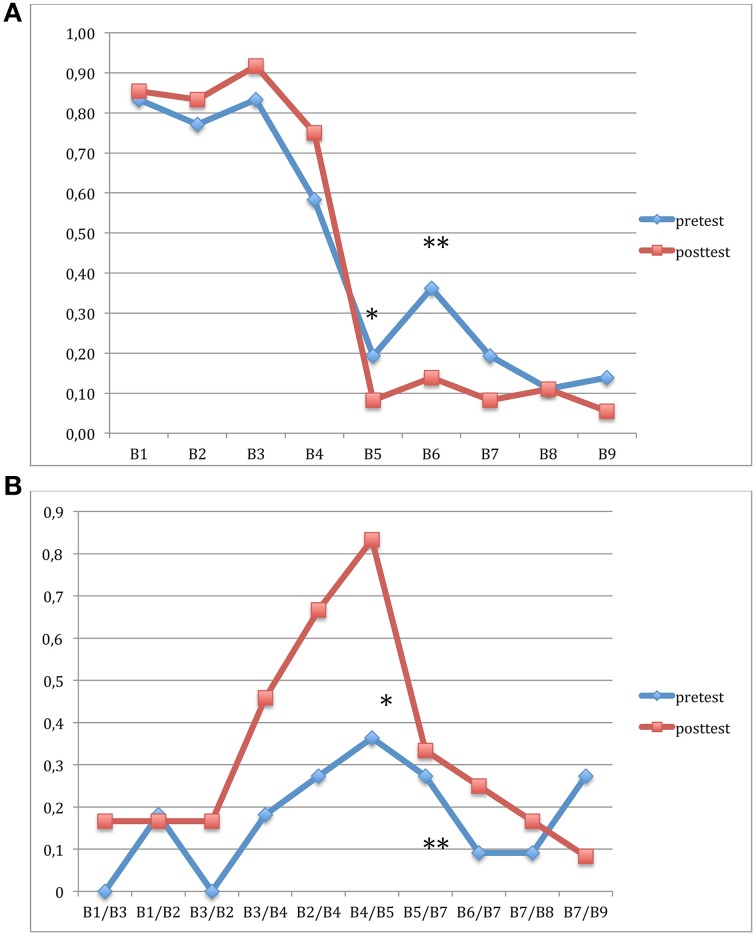
Categorical perception in Experiment 2. (A) Identification of syllables [pa] and [ba] within a 9-step acoustical continuum. The hit rate was significantly higher after than before 6-week of CMT for B5 and B6. (B) Discrimination: The hit rate is significantly higher for B4/B5 and B5/B7 pairs (i.e., around the categorical boundary) after than before CMT. *p < 0.05; **p < 0.01.